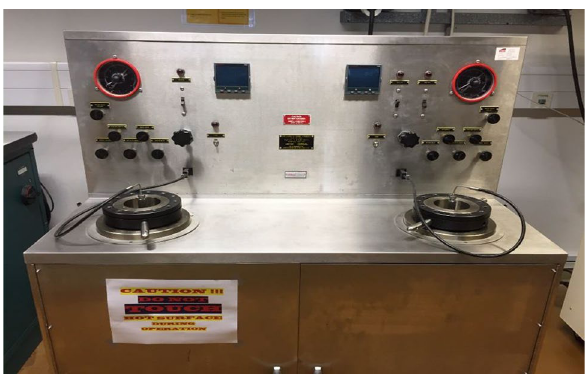
Fig. 5 Curing chamber for testing well cements